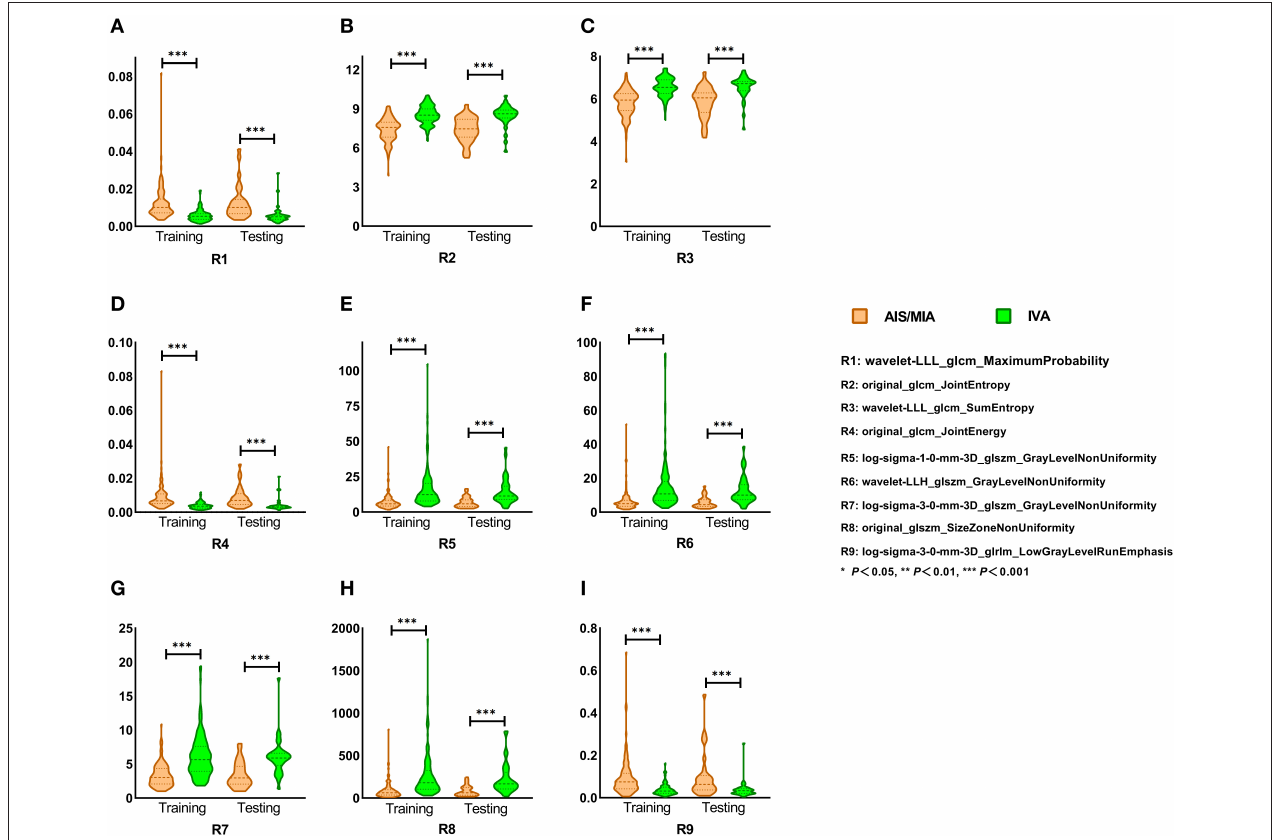
FIGURE 3 | (A–I) Selected radiomic features in training and test cohort. Nine selected radiomic features showed significant difference between AIS/MIA and IVA in both training and test cohorts. Maximum Probability, Joint Energy, and Low Gray Level Run Emphasis had larger median values for AIS/MIA, while the median values of Joint Entropy, Sum Entropy, Gray Level Non-Uniformity, and Size Zone Non-uniformity were higher for IVA in both training and test cohorts.